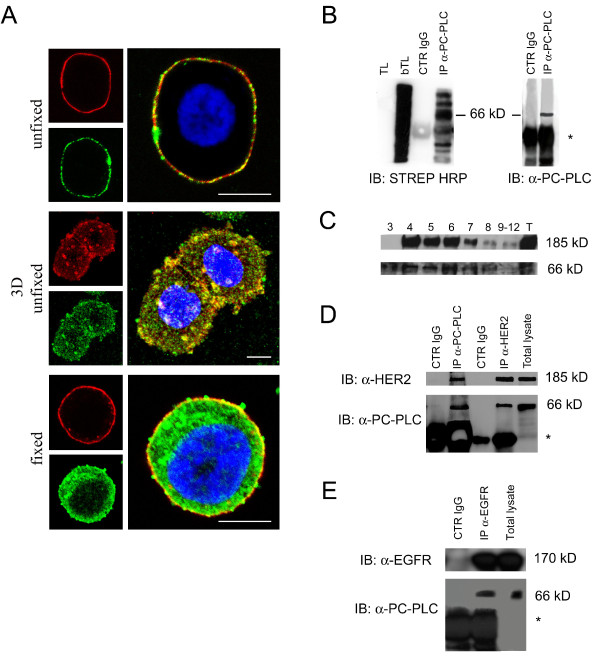
Colocalization of PC-PLC and HER2 on plasma membrane of SKBr3 cells. (a) CLSM detection of PC-PLC and HER2 in either unfixed (top and middle panels) or fixed and permeabilized SKBr3 cells (bottom panel) by using rabbit polyclonal α-PC-PLC (green) and α-HER2 W6/100 mAb (red). Colocalization areas are represented in yellow. The middle panel shows the tridimensional reconstruction of PC-PLC and HER2 expression on the plasma membrane. Scale bars, 8 μm. At least five independent series of experiments were performed for each condition. (b) PC-PLC immunoblotting analyses of immunoprecipitated biotinylated proteins isolated from SKBr3 cells, detected by streptavidin-HRP (left, IB:STREP HRP) or by α-PC-PLC (right, IB:α-PC-PLC). TL, total lysate; bTL, biotinylated total lysate; CTR IgG, control for α-PC-PLC IgG; IP α-PC-PLC, α-PC-PLC immunoprecipitates. *IgG heavy chains. (c) Sucrose gradient fractions isolated from SKBr3 cell lysates and analyzed by Western blotting for HER2 (185 kDa) and PC-PLC (66 kDa) detection. T, total cell lysate. (d, e) Western blot analyses of α-HER2 and α-PC-PLC (d) and α-EGFR and α-PC-PLC (e) immunoprecipitates (IP), blotted with the mutual Abs (α-PC-PLC, α-HER2, and α-EGFR, respectively), compared with the respective controls (CTR IgG α-PC-PLC, CTR IgG α-HER2, CTR IgG α-EGFR). Panels b, c, d, show representative results of three independent experiments. The immunoprecipitation in panel e was repeated twice.